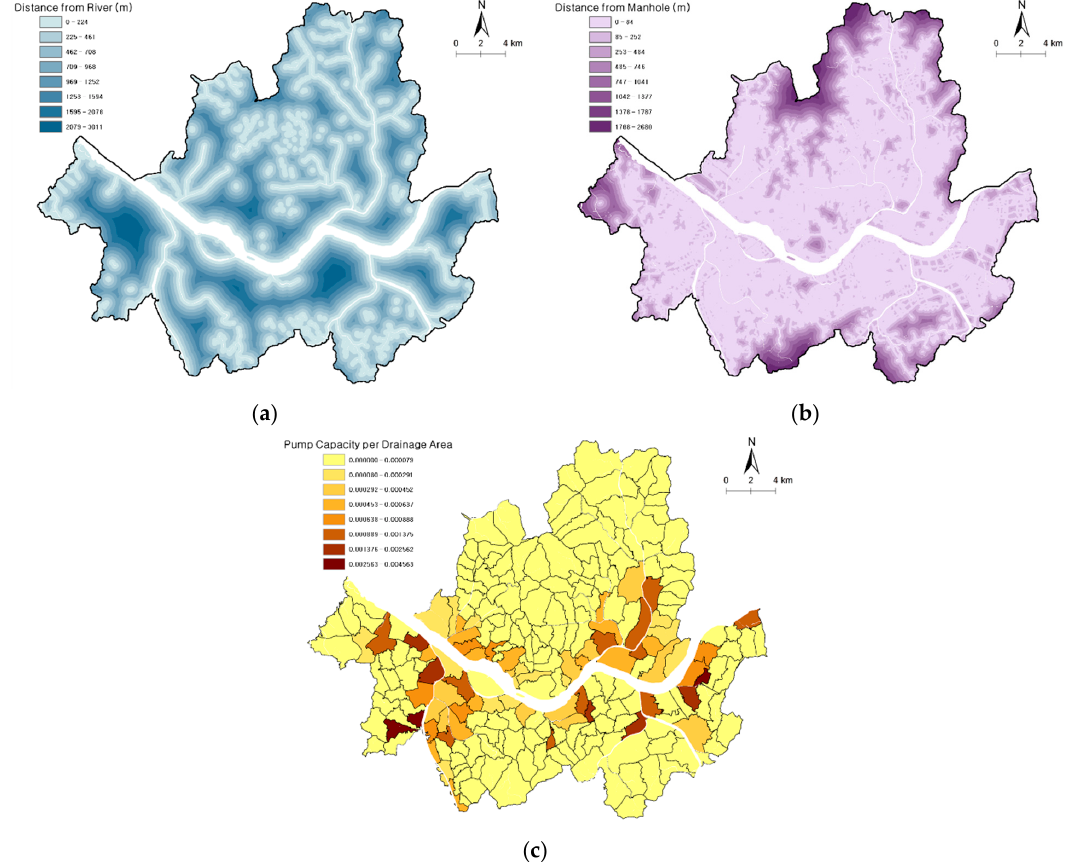
Figure 5. Locational and resistant factors: ( a ) Distance from river; ( b ) Distance from manhole; ( c ) Pump capacity per drainage area.